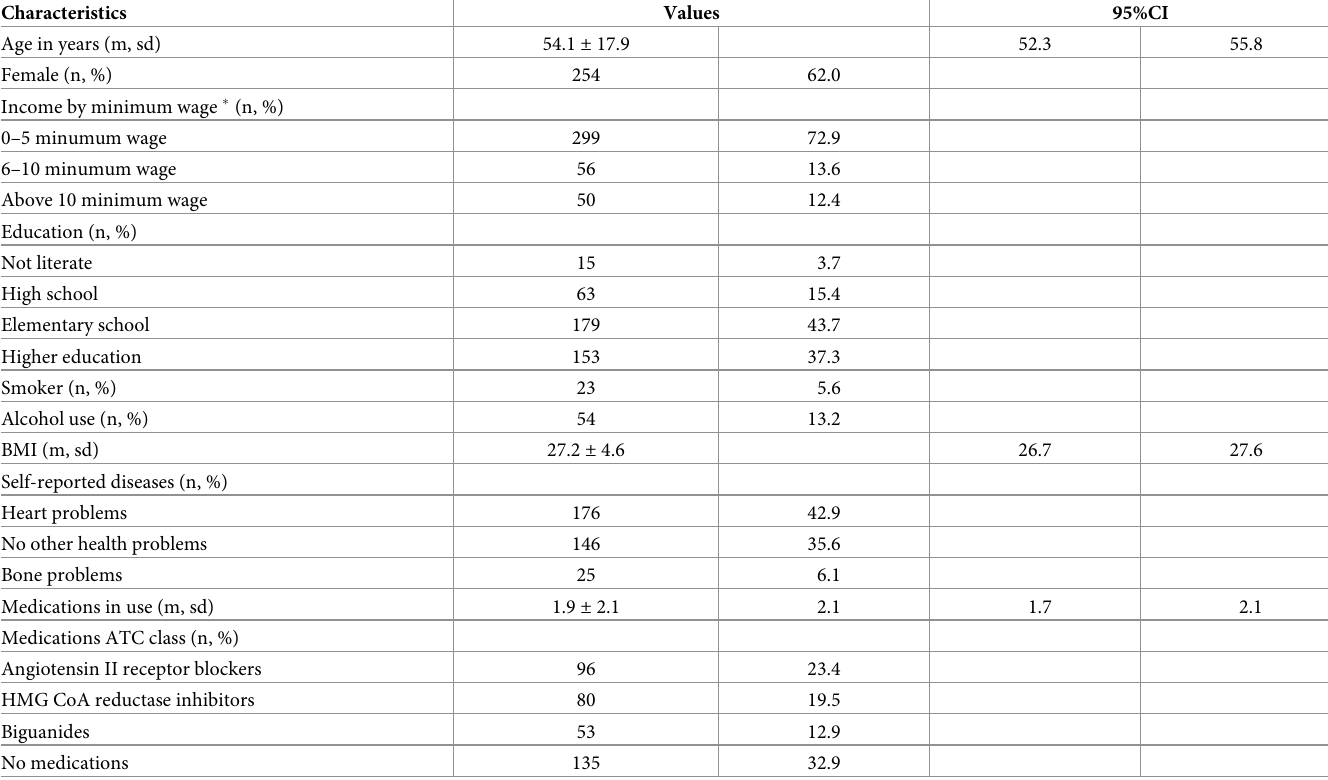
Table 1. Characteristics of